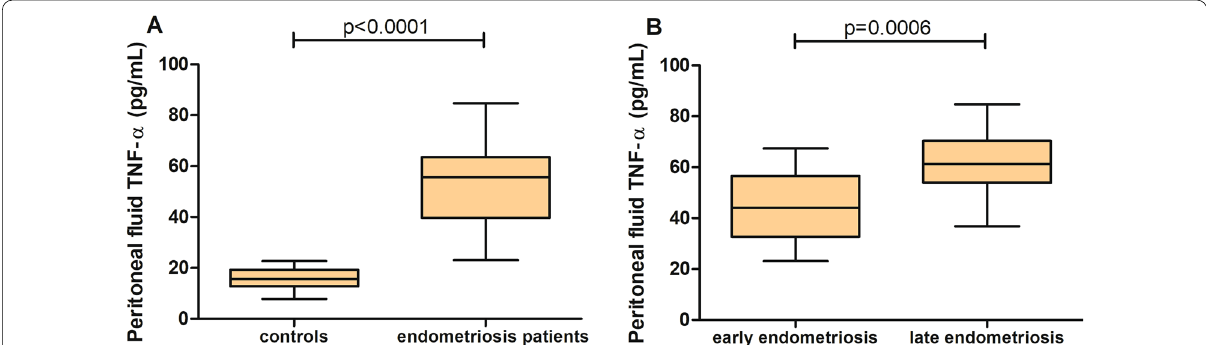
Fig. 4 Higher levels of TNF-α in peritoneal fluid of endometriosis patients compared to control females ( A ) and in late stages of endometriosis compared to early stages ( B )